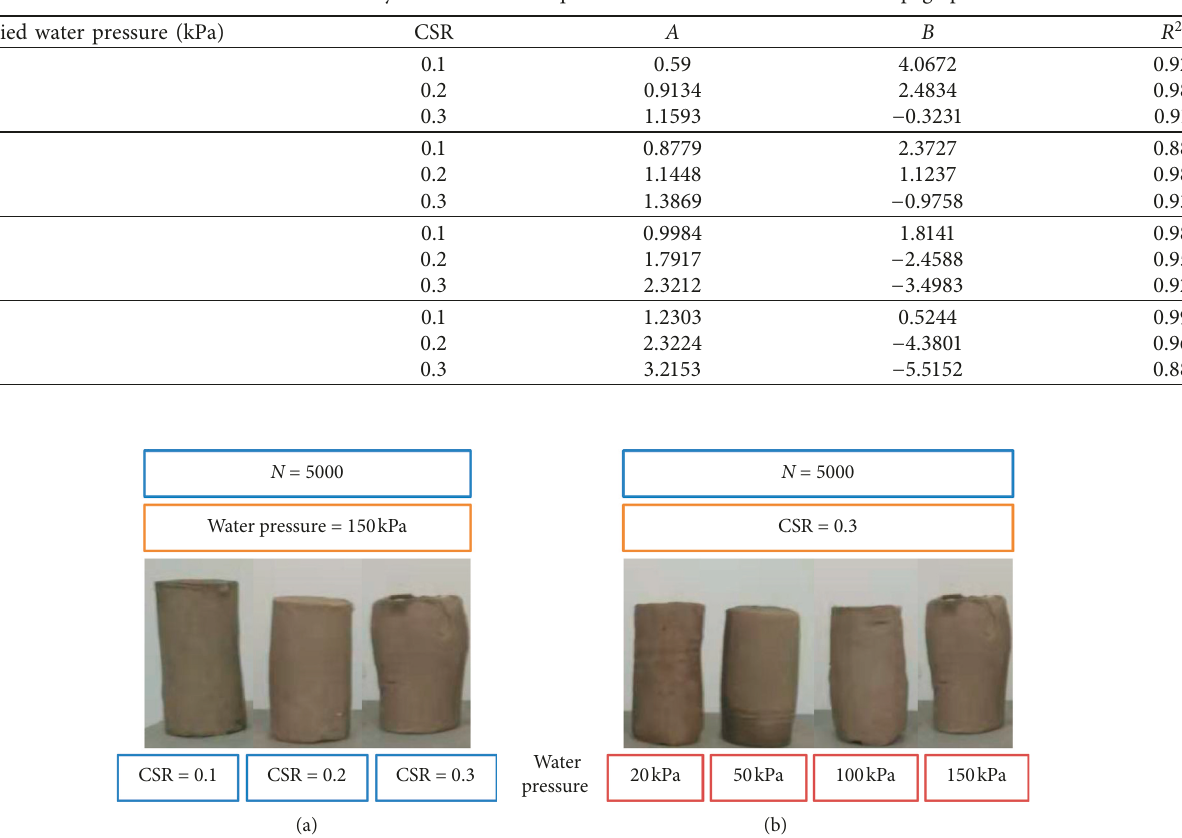
Figure 11: Variation in dynamic modulus with N : (a) different CSR values; (b) different seepage Table 4: Parameters for the dynamic modulus equation under different CSRs and seepage pressures.